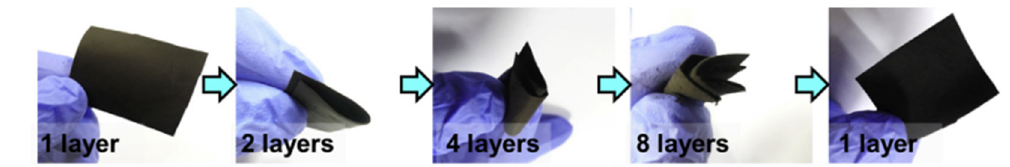
Figure 5. Folding process of FGCZ composite. Reprinted with permission from [133]. Copyright 2019, Elsevier.